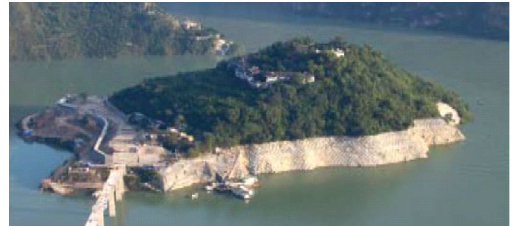
Figure 1: The famous scenic spot at the Three Gorges Reservoir, Baidicheng, whose reinforcement slope is designed to resist periodic reservoir fl uctuations [1].